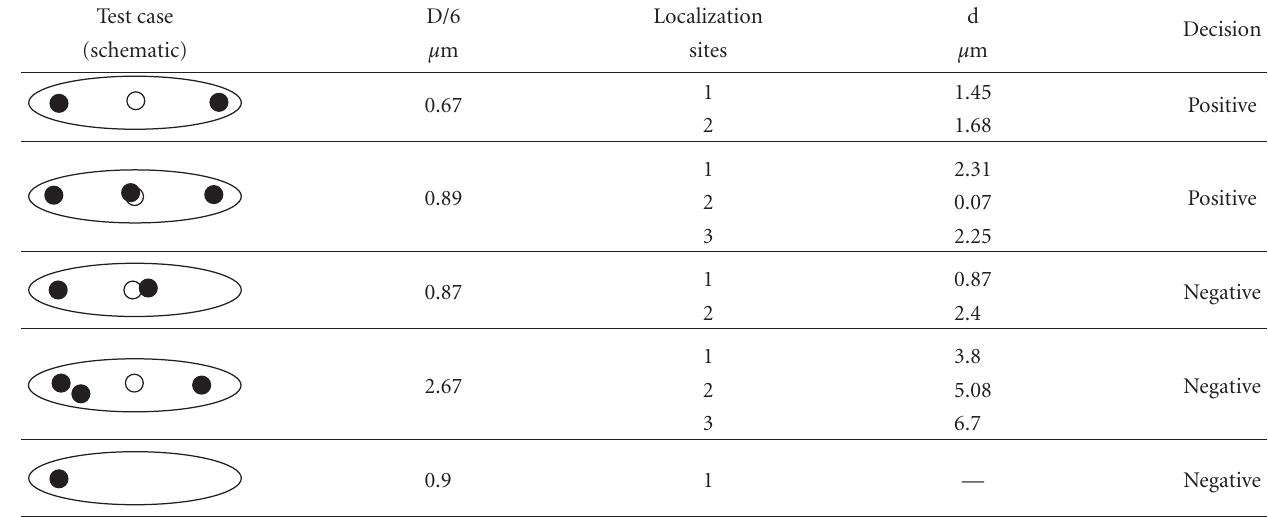
Table 1: Examples of GFP-fusion protein localization patterns and features used to derive a positive or negative